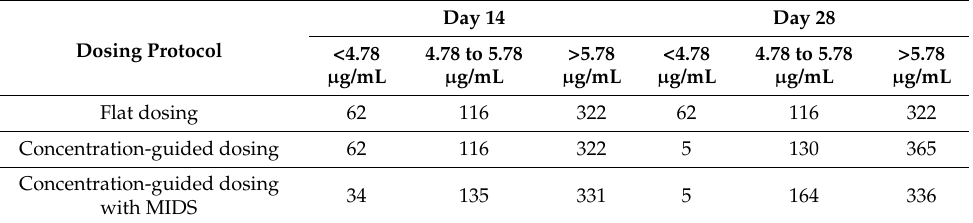
Table 3. Number of participant below, within and above target concentration range with different sorafenib dosing